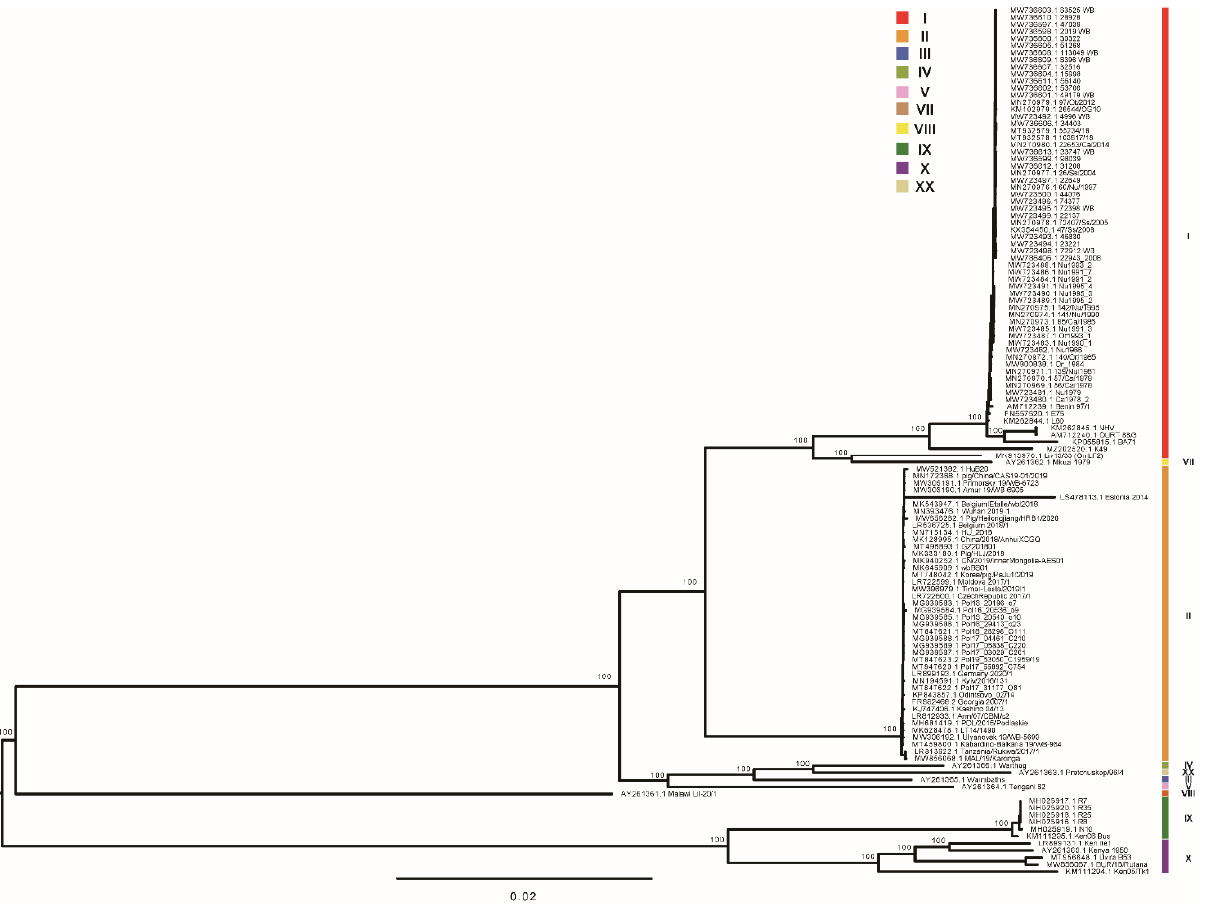
Figure 2. Maximum likelihood phylogenetic tree of ASFV genome sequences in the curated dataset. The tree is midpoint rooted. The scale bar is given in numbers of substitutions per site. Bootstrap resampling (1000 replications) support values are shown at the nodes.